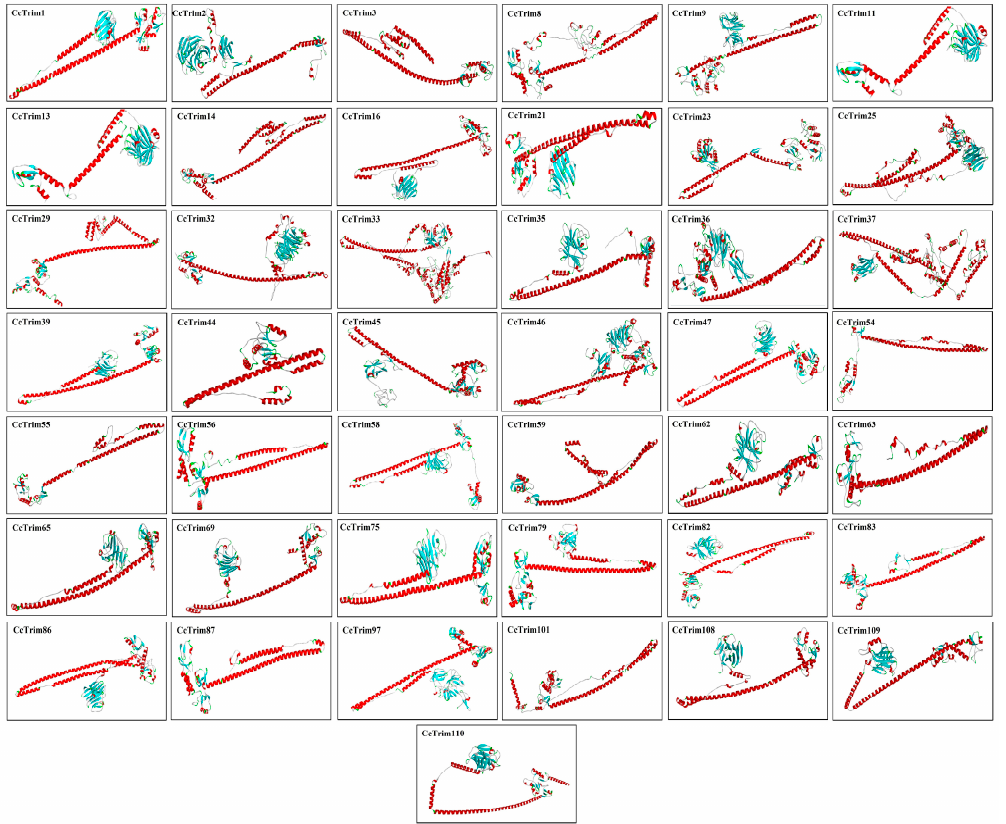
Figure 6. Predicted 3-D Superimpose structure of common carp TRIM proteins. The Red colour in the 3D structure indicates α helices, cyan colour represents the β sheets, white colour indicates the loop regions whereas, green colour indicates turns.